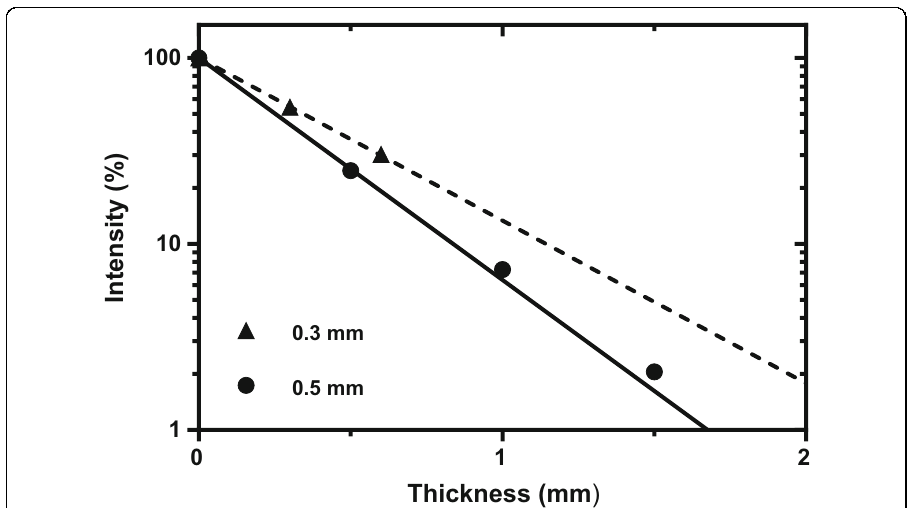
Fig. 16 Beam intensity through SLM tungsten disks printed at different nominal